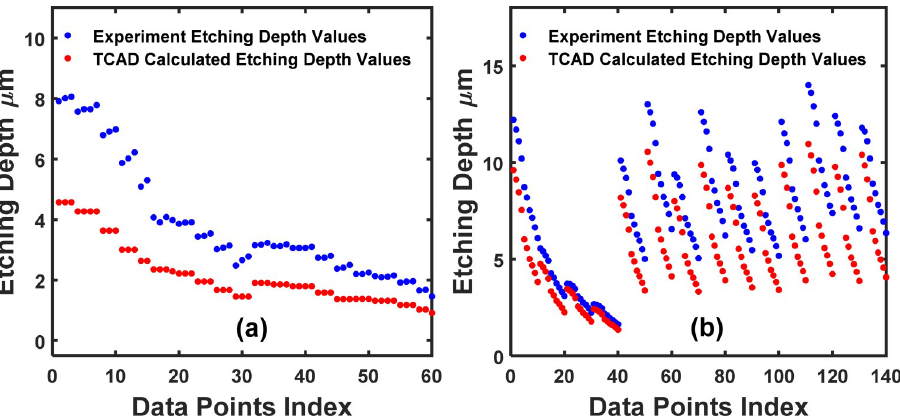
Fig 9. Datasets (a) 2-input dataset; (b) 5-input dataset; both the experimental and TCAD datasets are